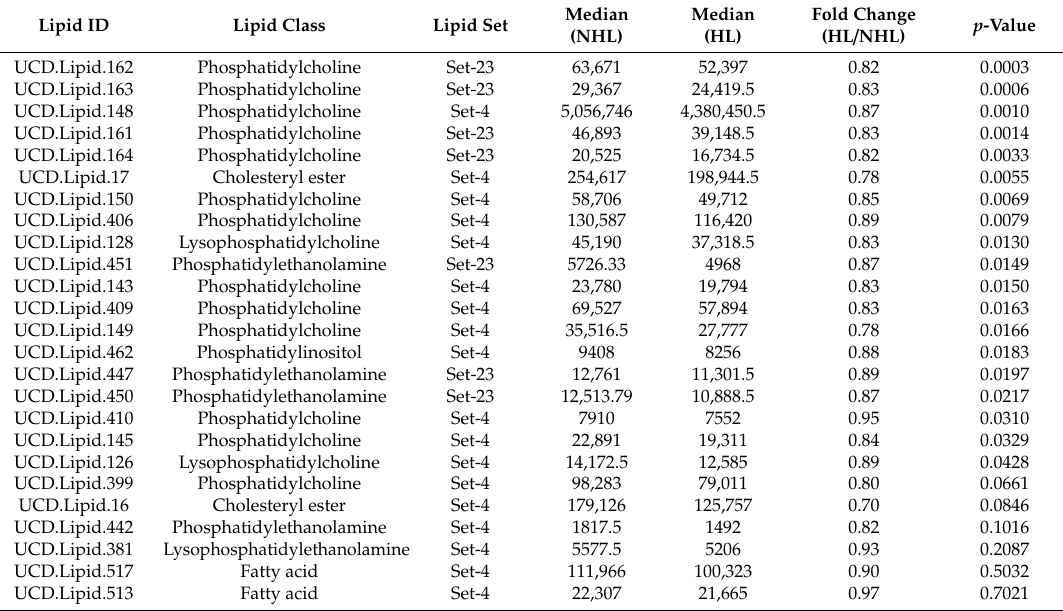
Table 5. Table of lipids derived from sets 4 and 23 from Barupal et al., 2019 and their performance in distinguishing HL from NHL subjects.